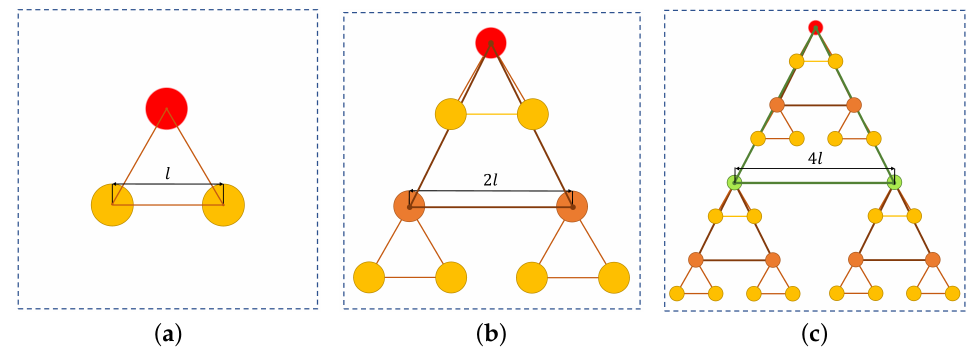
Figure 8. Illustration of the formation expansion method. ( a ) Formation of 3 UGVs. ( b ) Formation of 9 UGVs. ( c ) Formation of 27